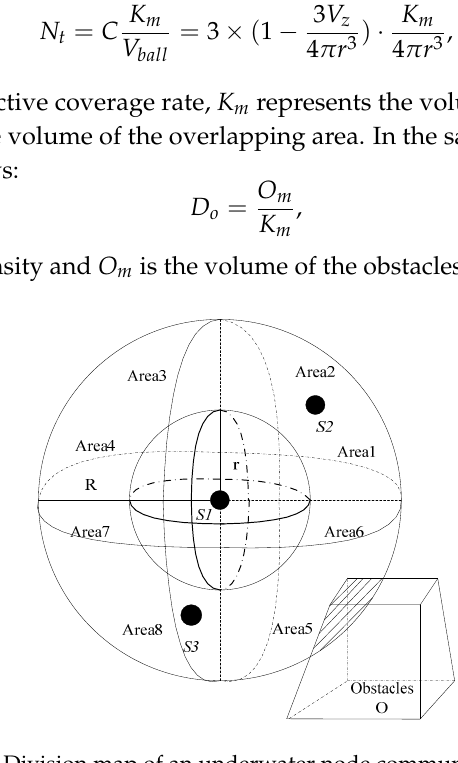
Figure 1. Division map of an underwater node communication area.